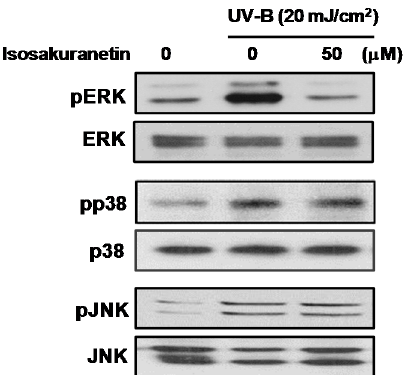
Figure 5. Effect of isosakuranetin on UV-B-induced phosphorylation of MAPKs in HaCaT cells. HaCaT cells were pretreated with indicated concentrations of isosakuranetin for 24 h and then irradiated with UV-B (20 mJ/cm 2 ), and then cells were further cultured for 1 h. Phosphorylation of ERK, JNK, and p38 MAP kinases was determined by specific antibodies against the phosphorylated form of MAP kinases.